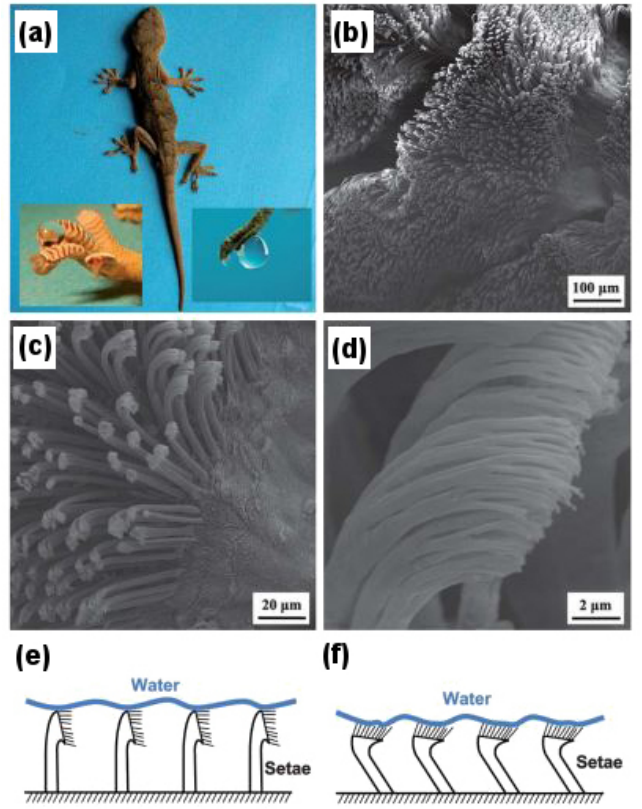
Figure 4. High-adhesion superhydrophobic surface of gecko feet. ( a ) Gecko lizard; the inset on the left shows the superhydrophobic character, and the inset on right shows the highly adhesive characteristic of gecko feet; ( b ) Scanning electron microscopy (SEM) image of the gecko foot at low magnification; ( c ) High magnification image of the gecko foot with visible microstructured setae; ( d ) nanostructured spatulae branching out from single seta in a high resolution SEM image; ( e ) Schematic of the superhydrophobic character of gecko setae with the water droplet; ( f ) Schematic of the highly adhesive character of gecko setae with the water droplet. Reproduced from [32] with permission of The Royal Society of